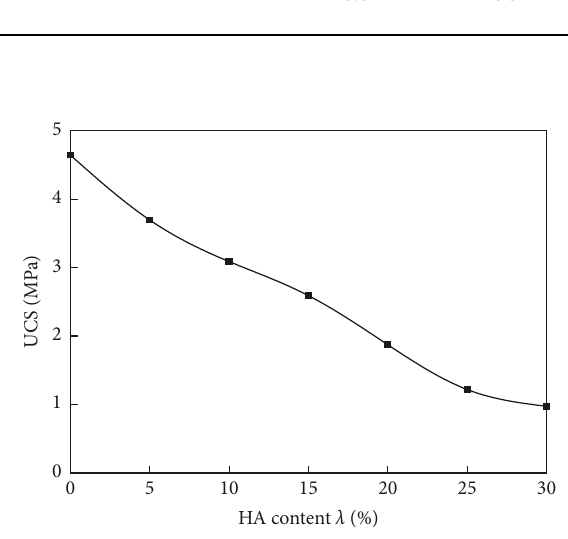
Figure 2: The relationship between UCS and HA content λ in cement-soil.